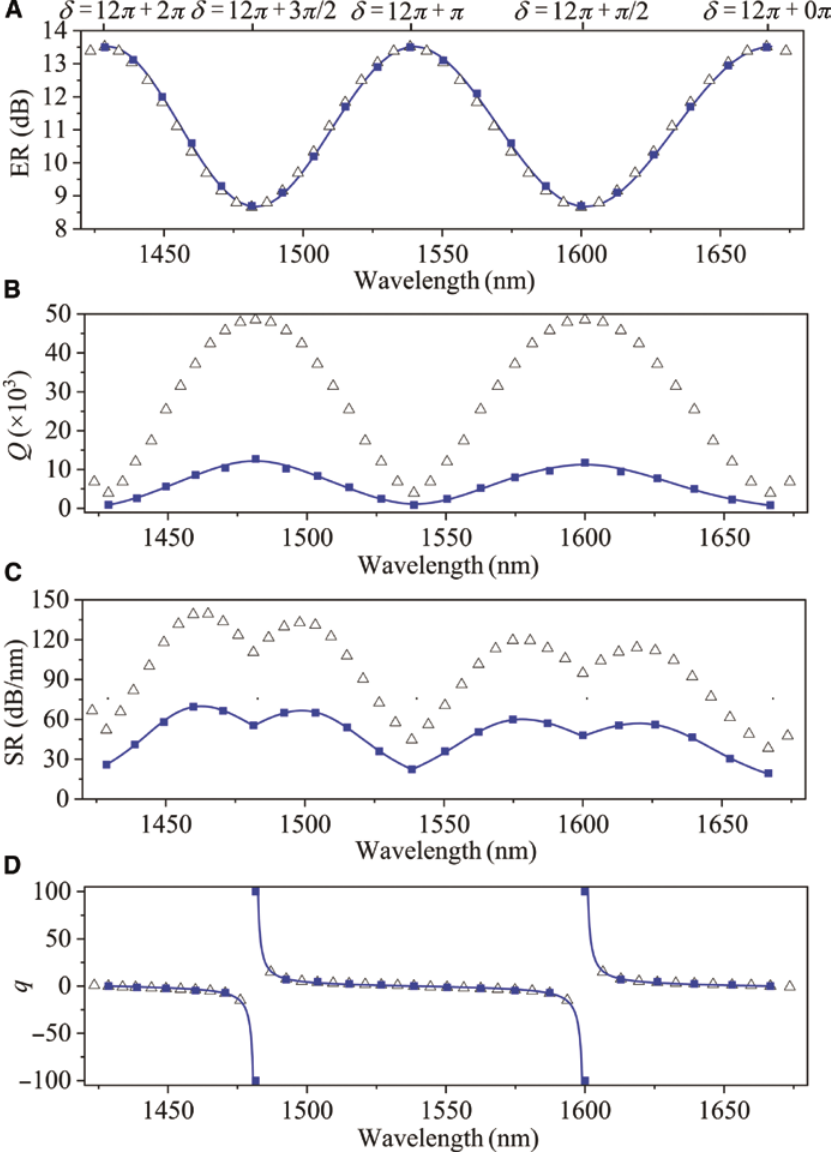
Figure 2: Distinct features of the resonance lineshapes from the proposed FP-MRR structure. (A) Extinction ratios, (B) Q factors, (C) Slope rates, and (D) Fano parameters ( q ) of the different resonance lineshapes in the FP-MRR spectrum with the parameter nL equaling to 200 (blue curves with squares) and 400 μ m (scattered triangular R